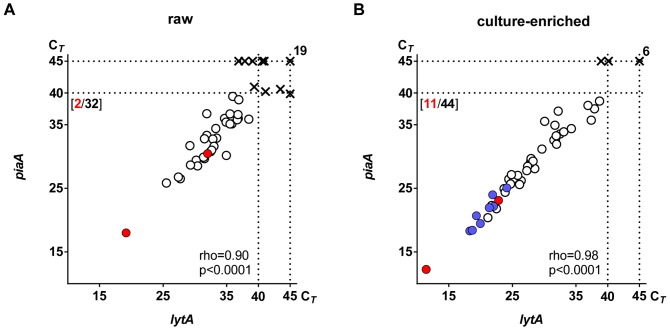
Detection of Streptococcus pneumoniae in saliva samples from schoolchildren.Results of qPCR-based detection of S. pneumoniae-specific genes lytA and piaA and of live S. pneumoniae isolation from raw (A) and culture-enriched (B) samples of saliva collected from 50 schoolchildren. Each dot or cross represents an individual sample. The position of symbols corresponds to CT values for lytA- and piaA-specific signals as marked on corresponding axes. Dots represent samples classified as positive for S. pneumoniae with qPCR. Red dots represent samples from which live pneumococci were isolated from primary cultures of raw saliva on gentamicin-supplemented plates inoculated on the day of sample collection (A and B). Blue dots represent additional samples from which live pneumococci were isolated from re-cultured gentamicin plate culture harvests (B). Crosses represent samples classified by qPCR as negative for S. pneumoniae. Dotted lines mark the threshold assigned to discriminate between positive (CT<40) and negative samples, and the total number of 45 cycles in each qPCR reaction. Numbers in square brackets depict (in red) the number cultures from which live S. pneumoniae was isolated and (in black) number of samples with CT values <40 for both targeted genes. The number in the upper right corner depicts the number of samples classified with qPCR as negative for S. pneumoniae. Spearman's rank correlation coefficient (rho) and the associated P value (p) for samples generating any lytA- or piaA-specific signal (CT<45) are shown.